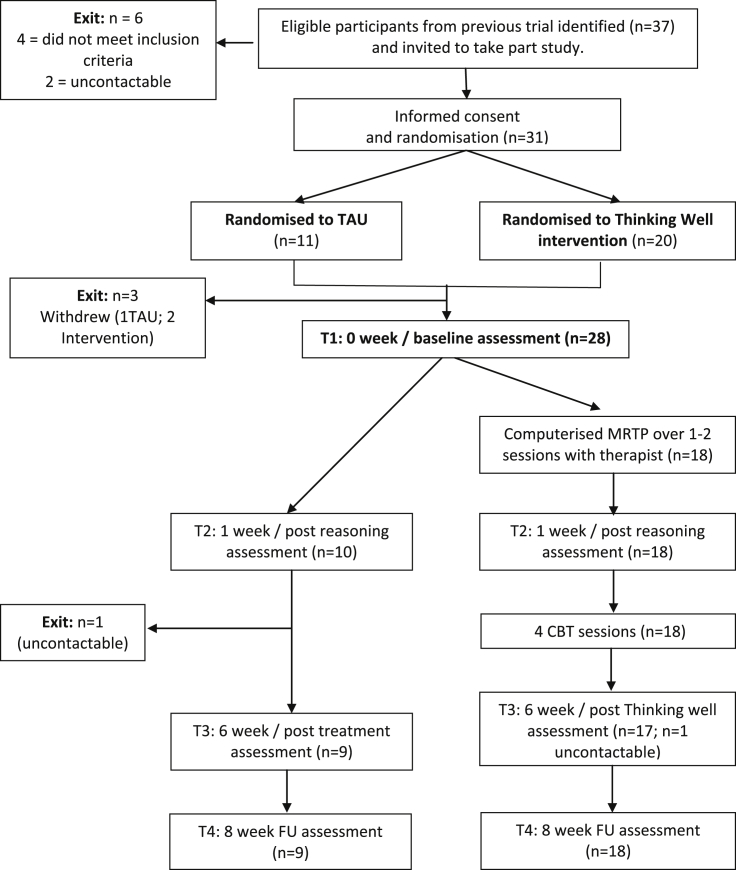
Consort diagram.